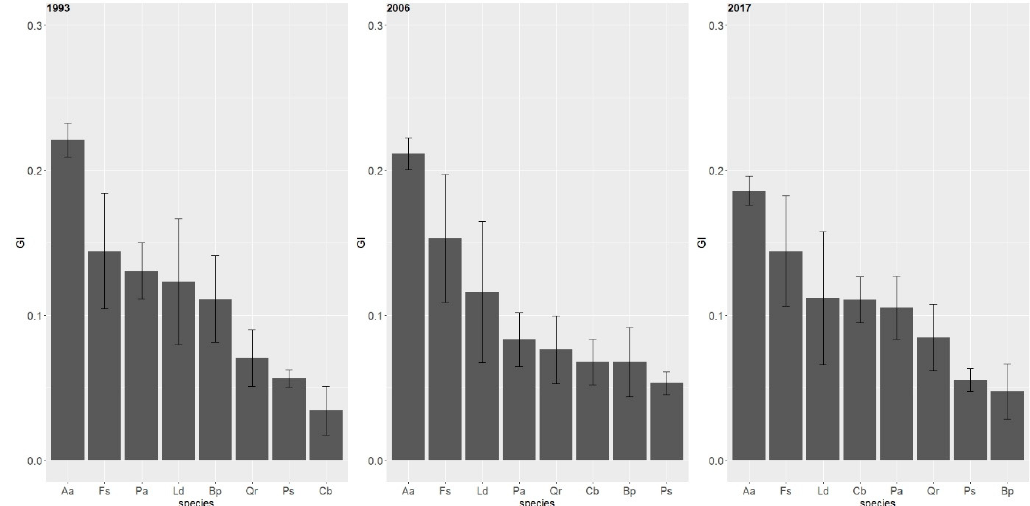
Figure 10. Species-specific mean value of Gini index (whiskers = standard error) for different years of observation in the multispecies, uneven-aged forest located in the Unieszów Forestry Range.